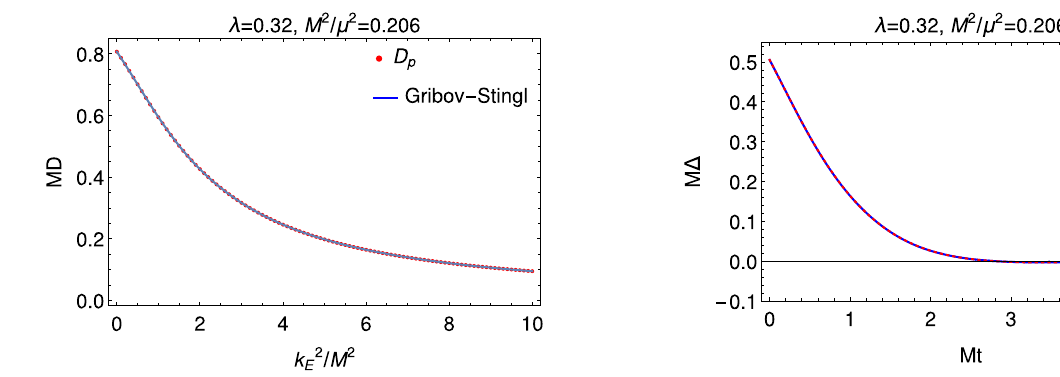
Fig. 21 The comparison between the pole part of the Schwinger func- tion calculated from the spectral function (blue solid line) and the Schwinger function calculated from the Gribov–Stingl fit (red dotted line), at the physical values of the parameters λ = 0 . 32, M 2 /μ 2 = 0 .